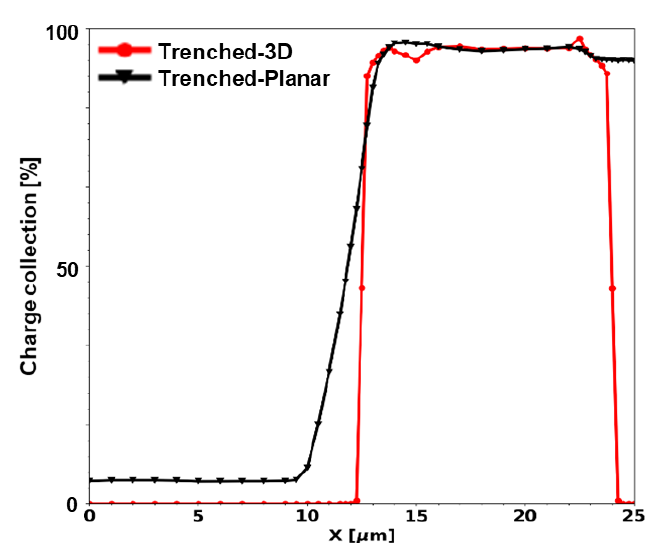
Figure 7. Comparison of the radial charge collection profiles for the Trenched-3D and Trenched-planar structures in response to a 5.5 MeV alpha particle for SOI thickness of 10 µm.